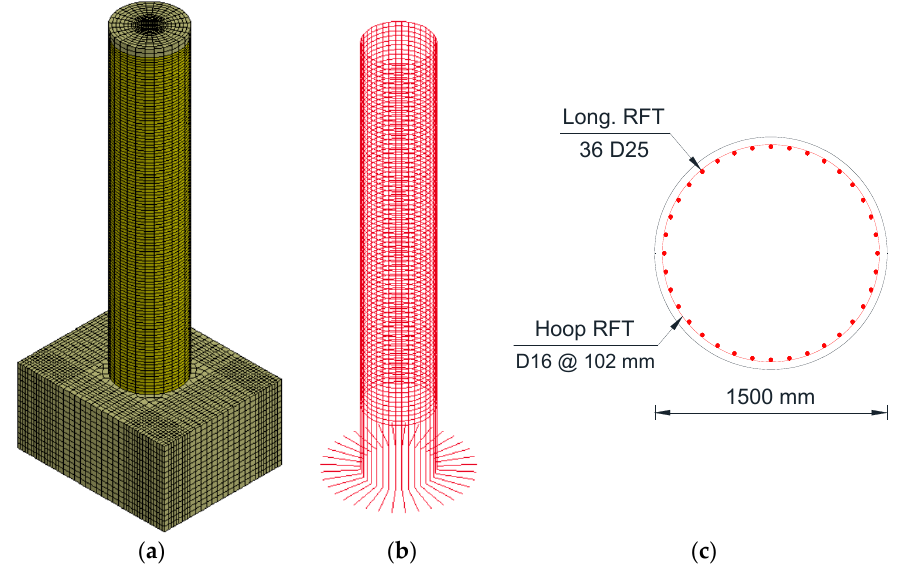
Figure 1. Modeling of the C0-R column: ( a ) overall view of the column and ( b ) longitudinal and hoop reinforcements; and ( c ) cross-section.